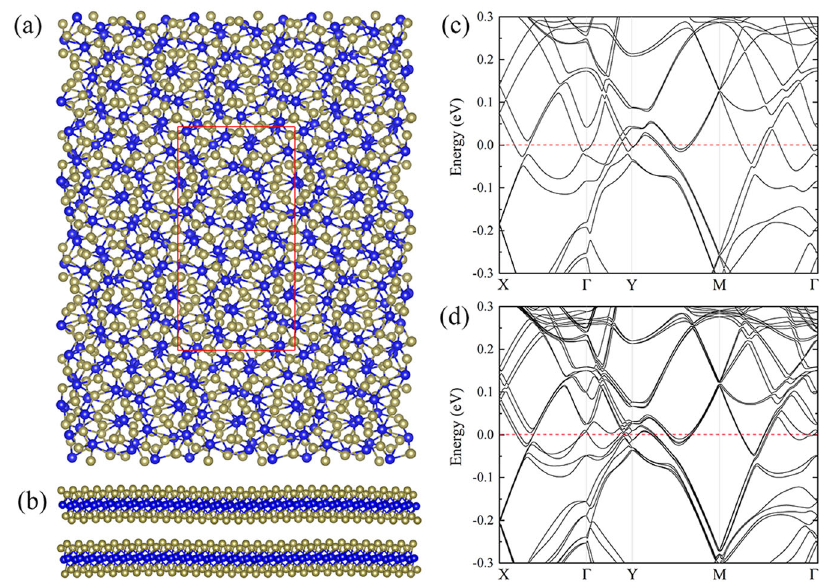
Fig. 2 Atomic structure and band structure of twisted bilayer WTe 2 . a , b The Moiré superlattice structure of twisted bilayer WTe 2 ( θ = 29.4°) in top view and side view, respectively. The red rectangle indicates the supercell. The blue and yellow balls represent W and Te atoms, respectively. c , d The band structure of twisted bilayer WTe 2 ( θ = 29.4°) without and with SOC,